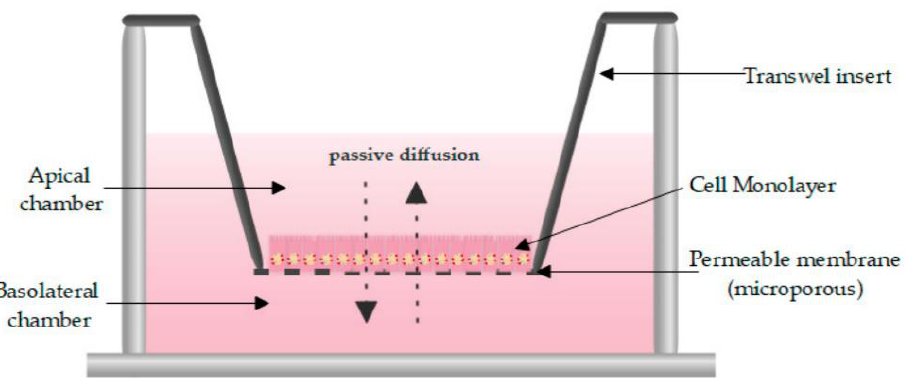
Figure 2. Schematic overview of a Caco-2 monolayer on a transwell insert. Adopted from [164], MDPI, 2019.